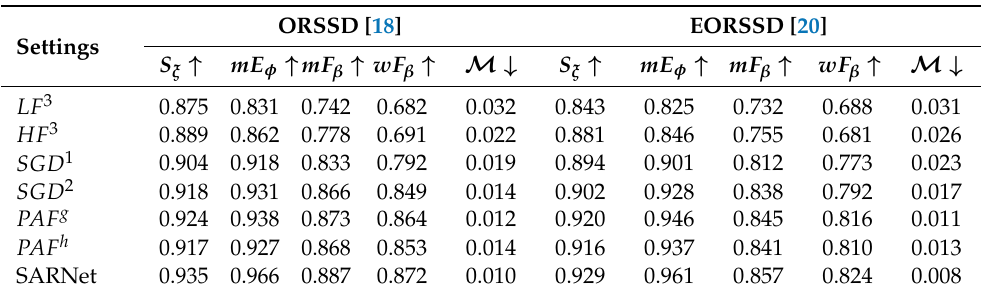
Table 3. Ablation study of different aggregation strategies on the ORSSD and EORSSD datasets. Settings